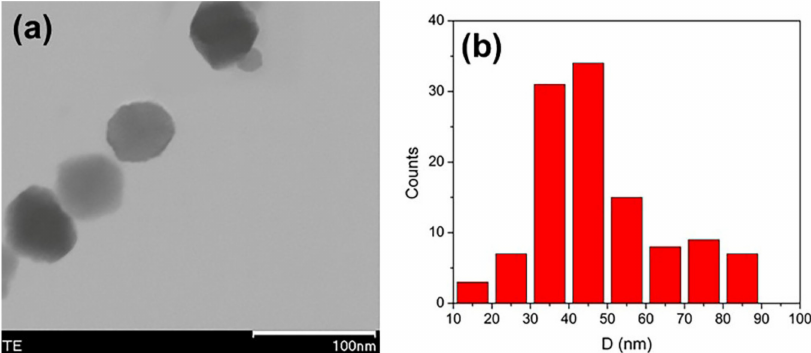
Figure 5. TEM image of stabilized magnetic nanoparticles MNP-AIm_1 ( a ) obtained by depositing 10 µ L of a suspension of each sample onto a copper grid coated with a thin carbon film and dry- ing it and size distribution (diameter) of the magnetic nanoparticles MNP-AIm_1 based on TEM measurements ( b ).